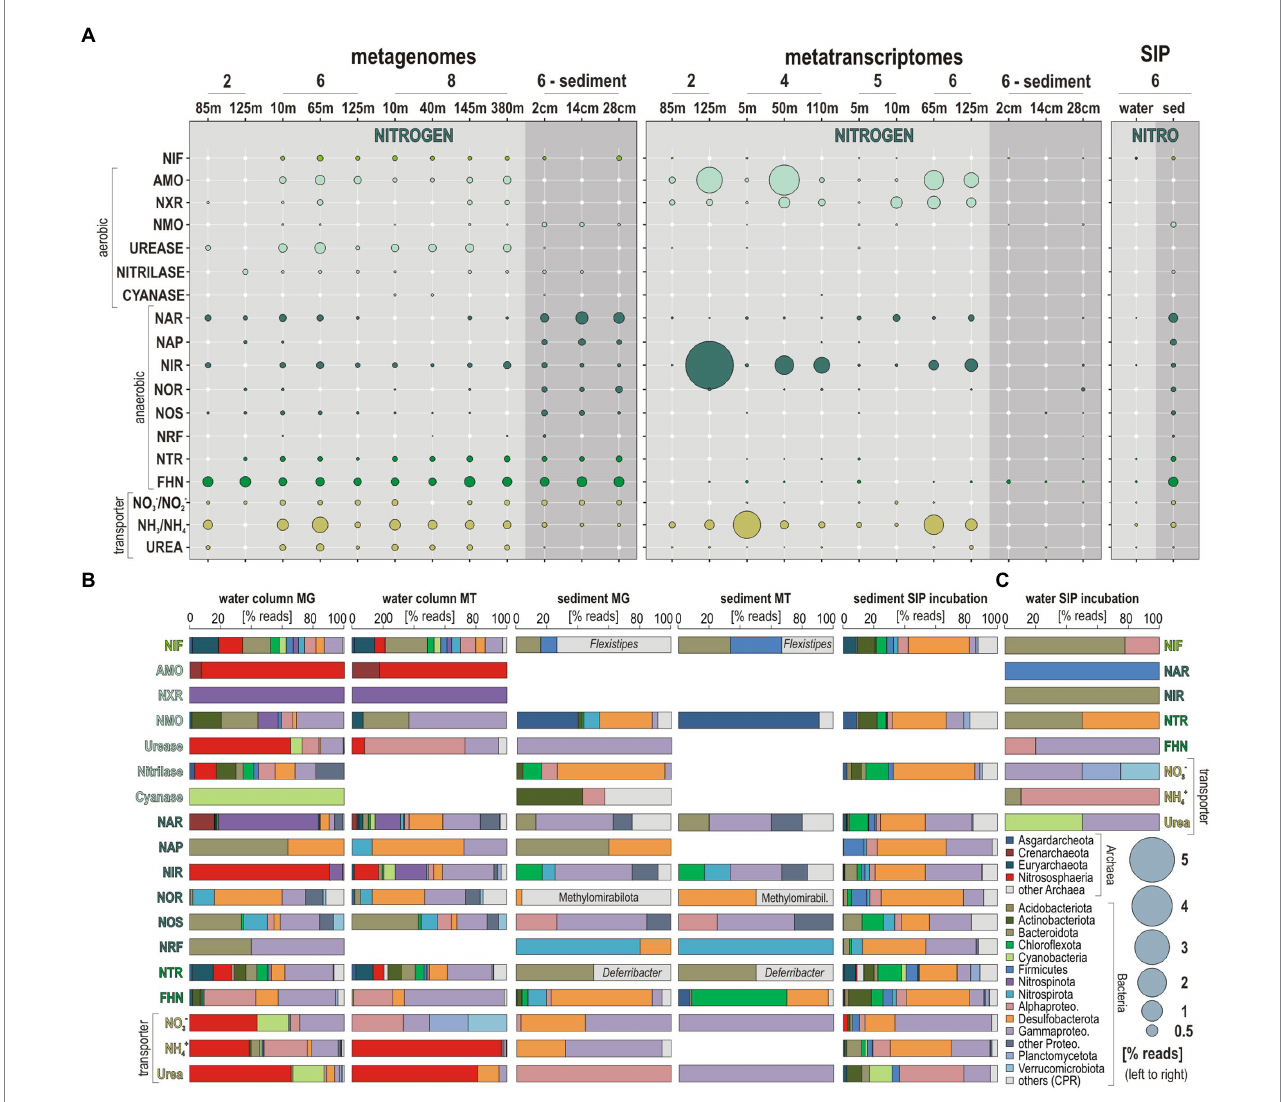
FIGURE 5 Metabolic functions and activities related to nitrogen cycling in the water column, sediment and SIP incubations, and the corresponding taxonomic assignments at the phylum level. (A) Bubble plot showing the relative potential and expression of metabolic functions [% total reads] assigned to nitrogen cycling in the metagenomes, metatranscriptomes, stable-isotope probing (SIP) water, and sediment incubations (left to right). (B) Taxonomic bar charts [% reads] for the corresponding functional marker genes related to nitrogen cycling at the phylum level in the metagenomes (MG), metatranscriptomes (MT), and anaerobic SIP incubations with sediment and 13 C-labeled bicarbonate (DIC). The last column on the left (C) displays taxonomy of functional marker genes identified in aerobic incubations with water and 13 C-labeled diatom mixture (dEPS). Abbreviations: NIF: nitrogen fixation/AMO: ammonium monooxygenase/NXR: nitrite oxidoreductase/NMO: nitronate monooxygenase/NAR: respiratory nitrate reductase/NAP: periplasmic nitrate reductase/NIR: copper-containing nitrite reductase/NOR: nitric oxide reductase/NOS: nitrous oxide reductase/NRF: ammonia-forming cytochrome nitrite reductase NTR: nitroreductases/FHN: formate